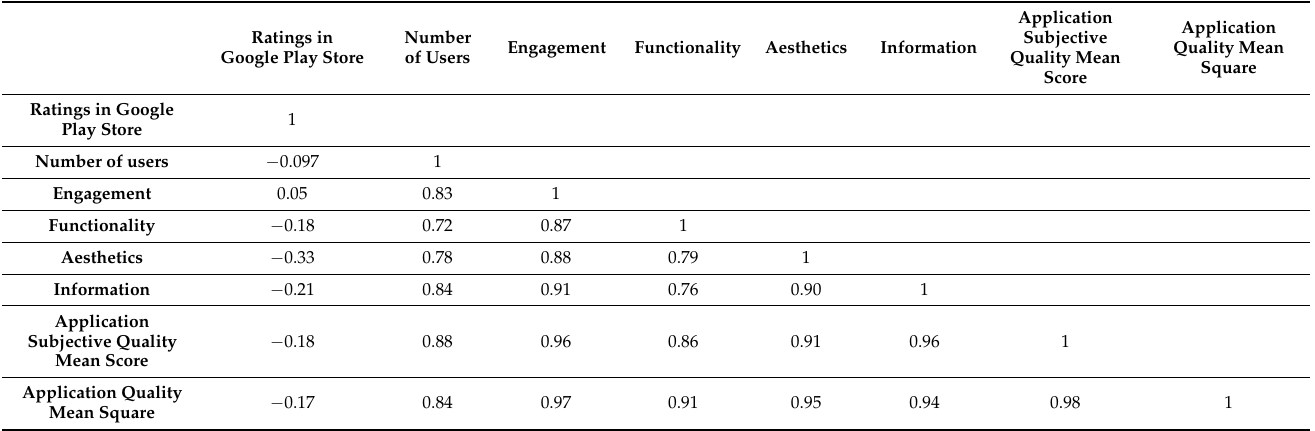
Table 7. Correlation between the major specifications of applications and the MARS